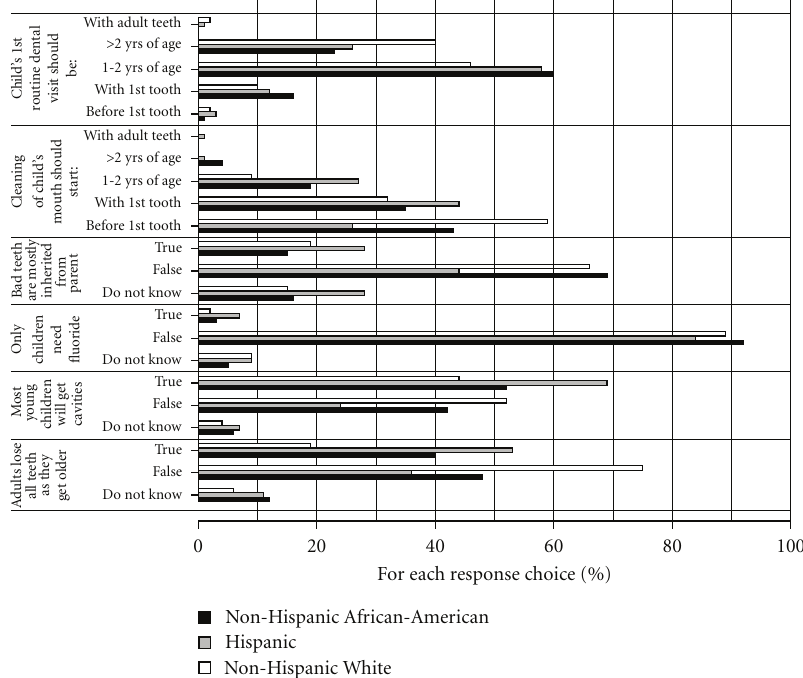
Figure 2: Relationships of race/ethnicity with dental beliefs of caregivers. Analyses were performed for each questionnaire item using multivariable logistic regression models with race/ethnicity, income, and education as predictors. Di ff erences among race/ethnicity groups were found for “cleaning should start” ( P = . 0001, earlier for Non-Hispanic Whites), “bad teeth are mostly inherited from parent” ( P = . 0119, lower response of “false” for Hispanics), “most children will get cavities” ( P = . 0304, lower response of “false” for Hispanics), and “adults lose all teeth as they get older” ( P = . 0001, higher response of “false” for Non-Hispanic